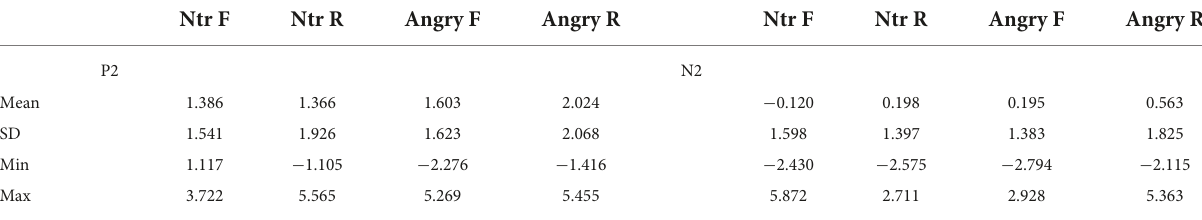
TABLE 2 Means and standard deviations for P2 and N2 ERPs elicited by cues following neutral (ntr) or angry faces.